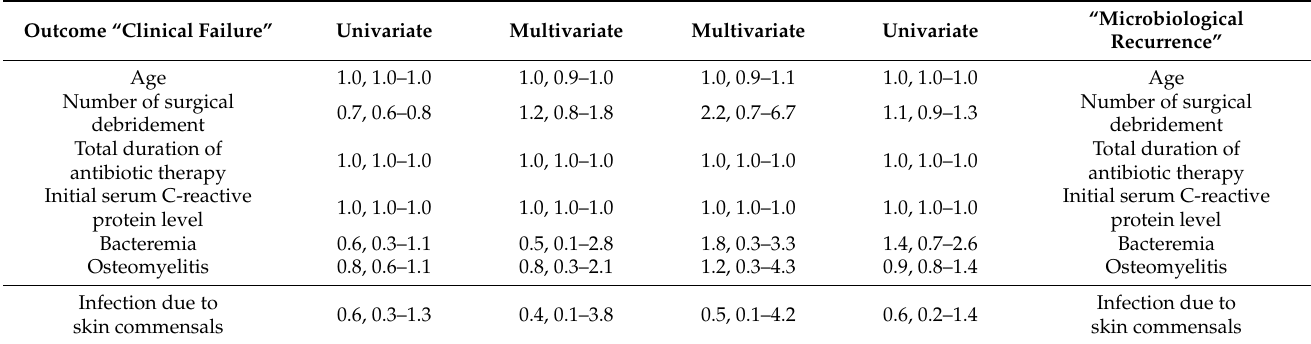
Table 2. Logistic regression analyses, stratified based on outcomes of “clinical failure“ and “microbio- logical recurrence”. Results are expressed as odds ratios with 95% confidence